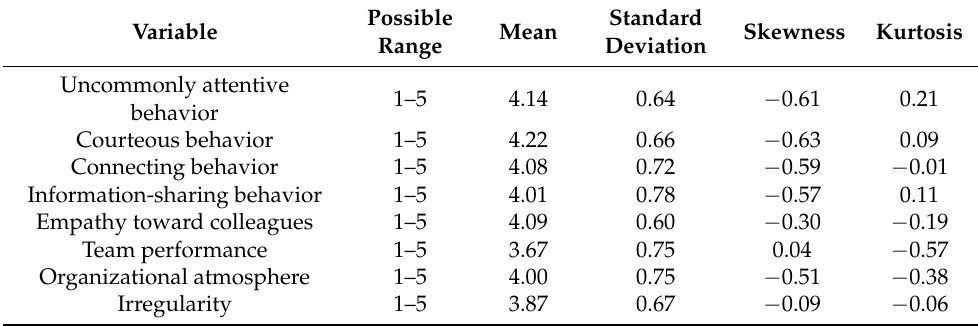
Table 5. Descriptive statistics of the major variables.